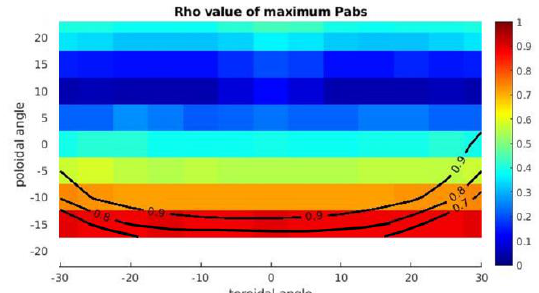
Figure 5: Location of the absorption in terms of normalized radius (colormap) depending on the injection angles for the lower mirror in optimal conditions. Contours define a few values of the absorbed fraction (0.7, 0.8, 0.9).